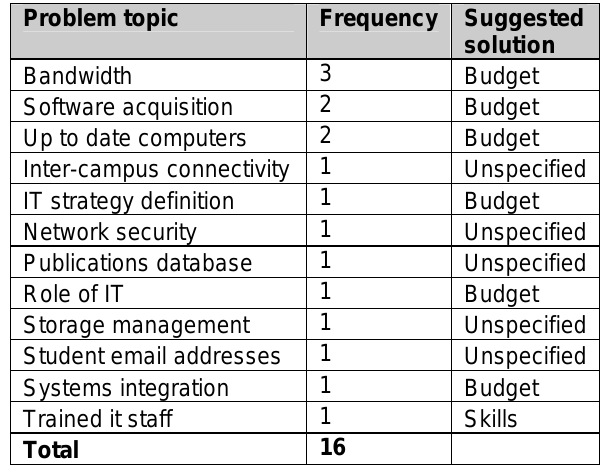
Table 7: Survey problems